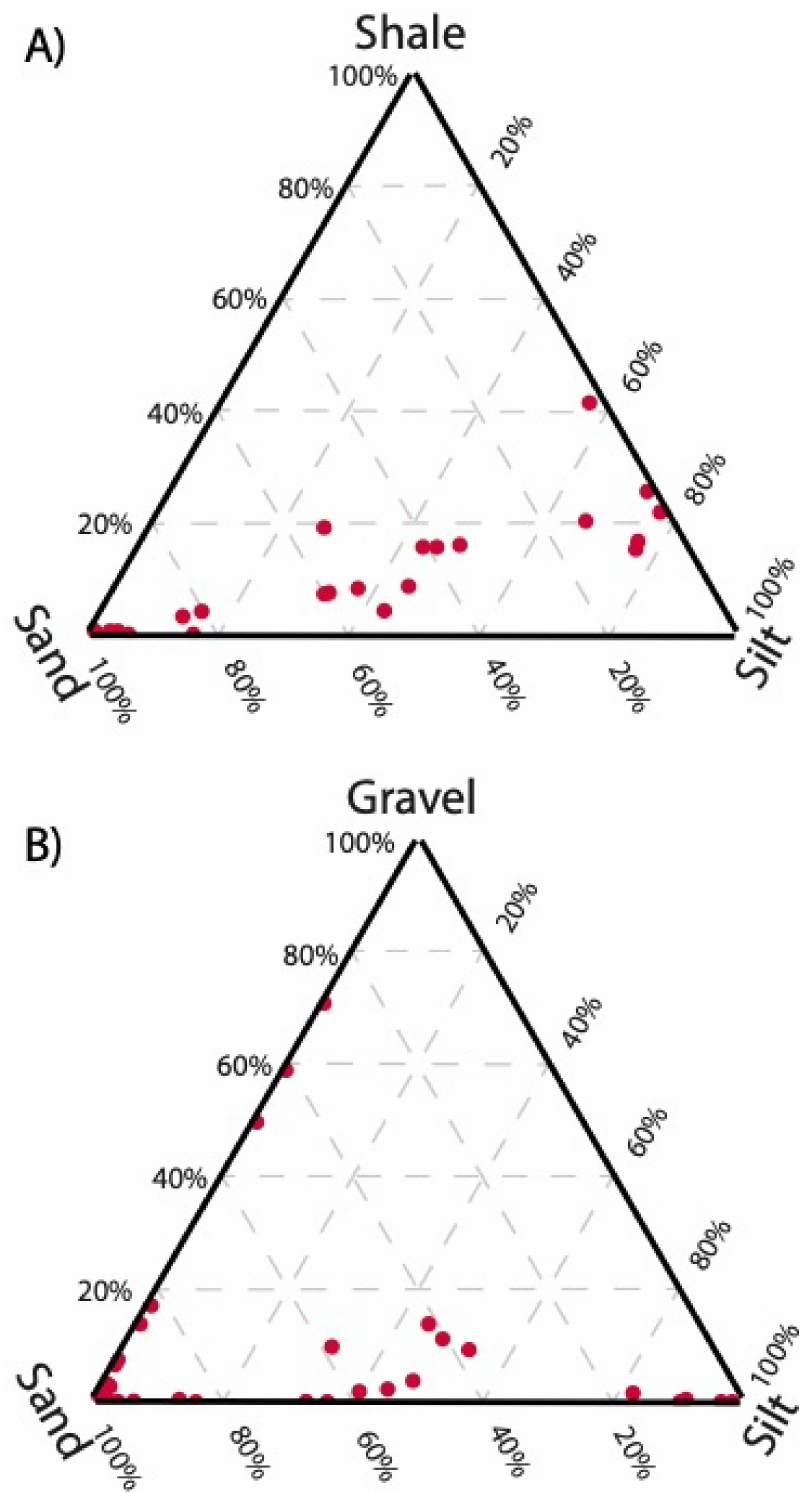
Figure 6. Ternary plots of the sea bottom samples. Inset ( A ) ternary plot shale–sand–silt. Inset (B) ternary plot